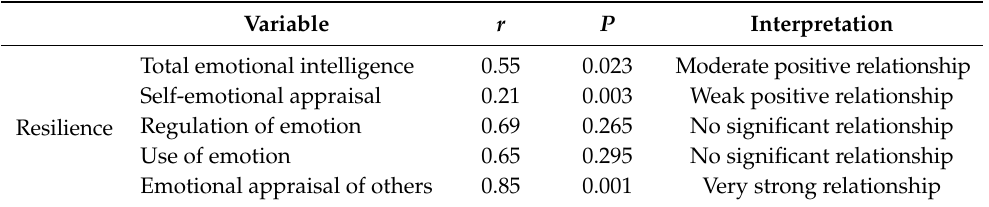
Table 3. Relationship between resilience and emotional